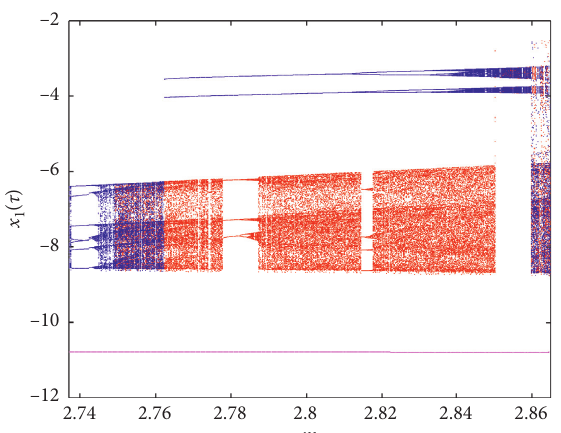
Figure 12: Enlargement of the bifurcation diagram of Figure 11(a) showing the region in which the system exhibits multiple coexisting attractors. This region corresponds to values of m in the range: 2 . 735 ≤ m ≤ 2 . 865. Three sets of data are superimposed. For more information about the methods used to plot, see Table